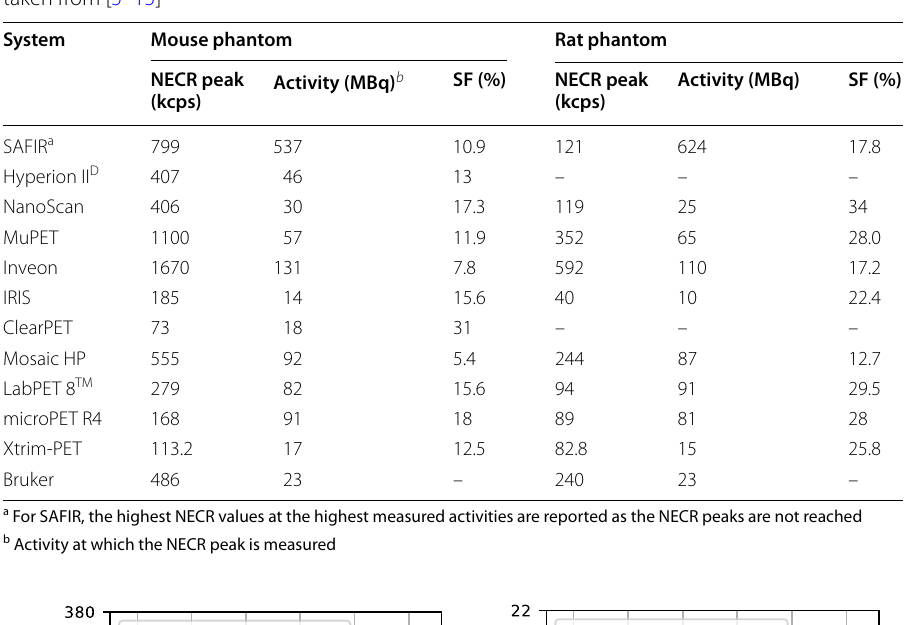
Table 5 Comparison of NECR and scatter fraction (SF) of different preclinical PET scanners. Data are taken from [5–15]